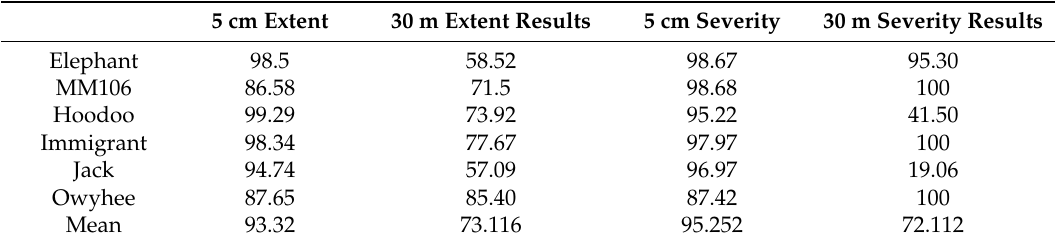
Table 1. Experiment Results Compared with the 5 cm from [19,22].